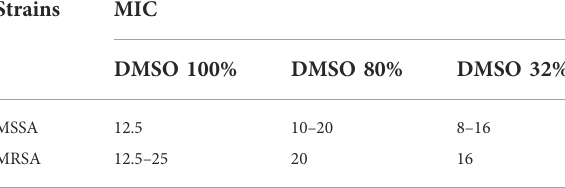
TABLE 1 MIC of DMSO designed in % (v/v) against MSSA ( n = 3) and MRSA ( n = 5) strains.